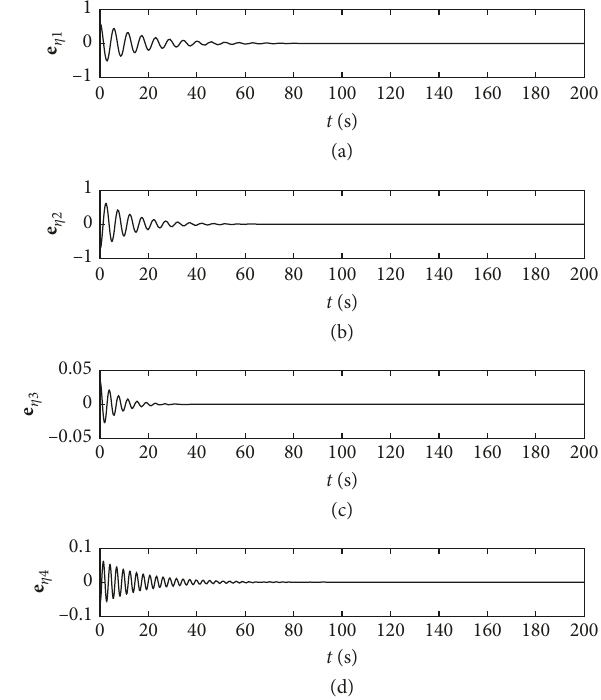
Figure 14: Time response of vibration estimate errors.